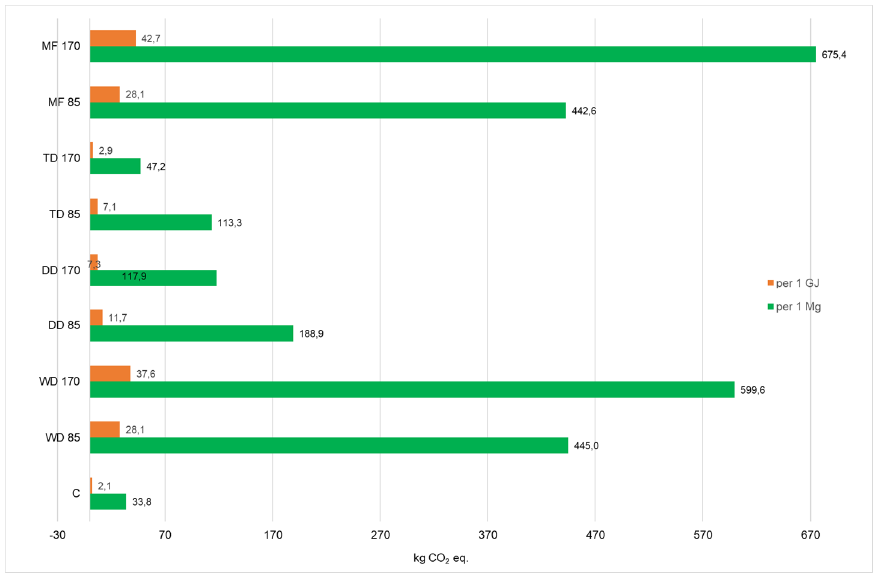
Figure 3. Greenhouse gases emission for miscanthus production in different fertilisation treatments.